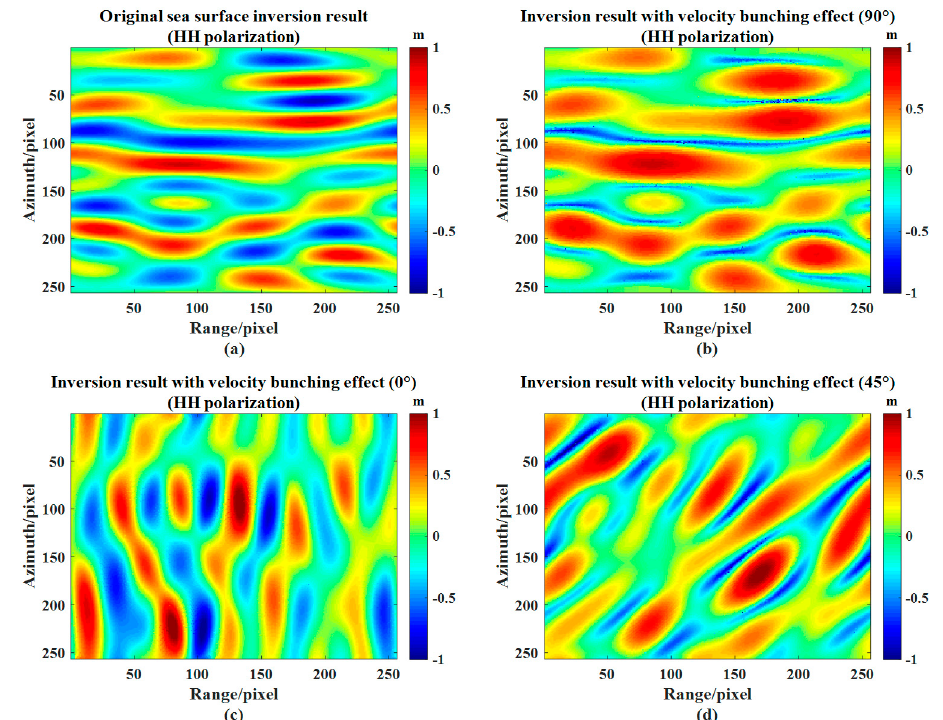
Figure 3. Simulation results of original sea surface ( a ) and added velocity bunching sea surface (in m). The swell propagation direction is 90° ( b ), 0° ( c ), and 45° ( d ) to the range direction.